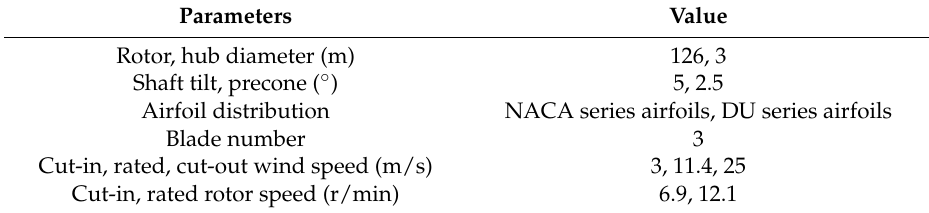
Table 3. Parameters of the rotor. The data in the table are from Jonkman et al. [23].